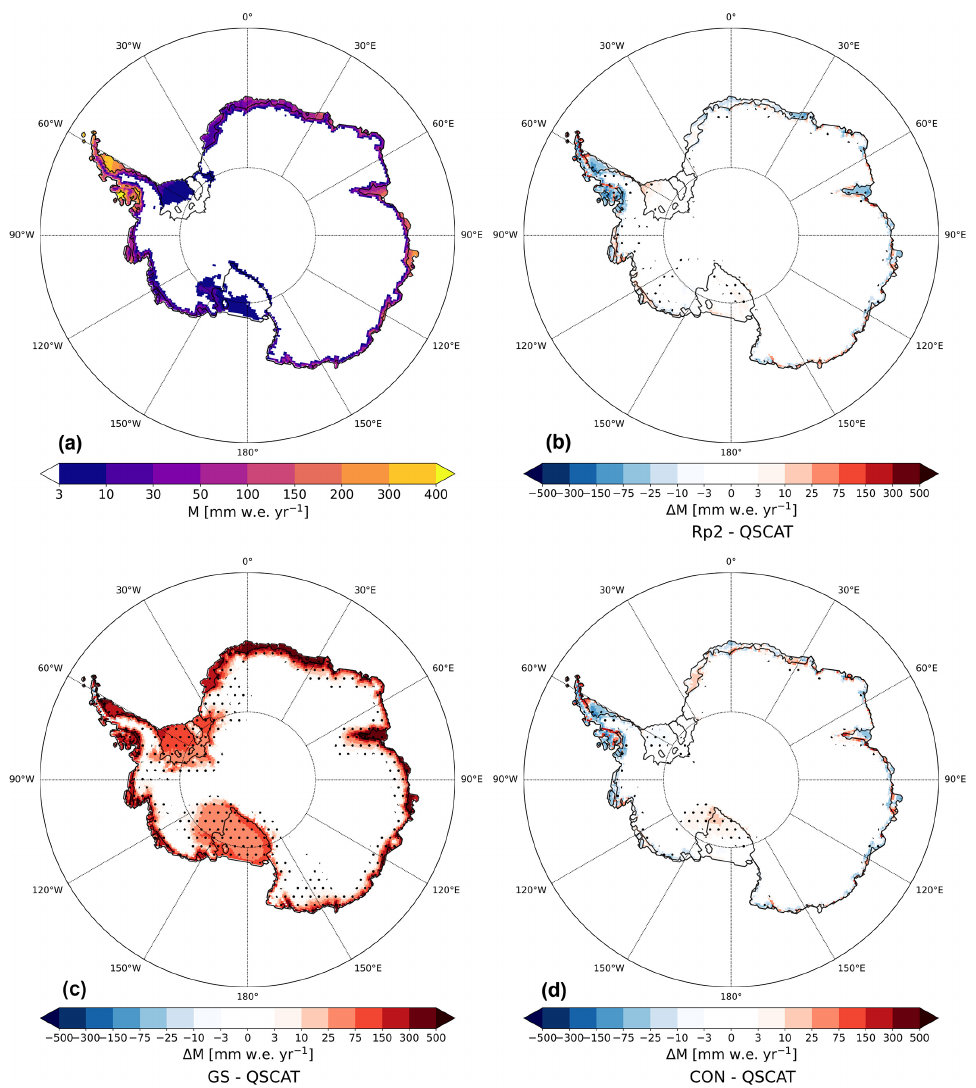
Figure 12. (a) Mean yearly-averaged melt in mmw.e.yr − 1 estimated by QSCAT; melt difference with QSCAT for (b) Rp2, (c) GS and (d) CON for 2000–2009. For (b) – (d) , positive values indicate a melt increase with respect to QSCAT. The dots represent